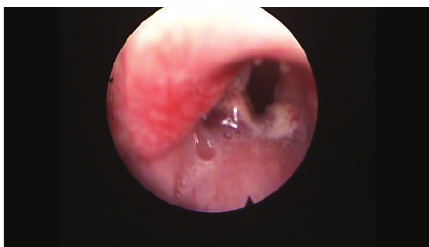
Figure 4: Scar tissue on bilateral vocal folds.